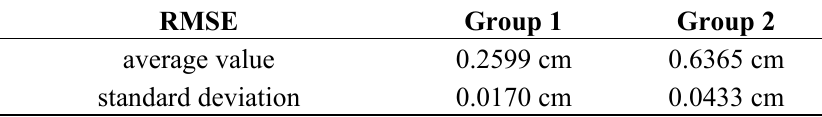
Table 3. The error distribution of SEMT in the first layout style.